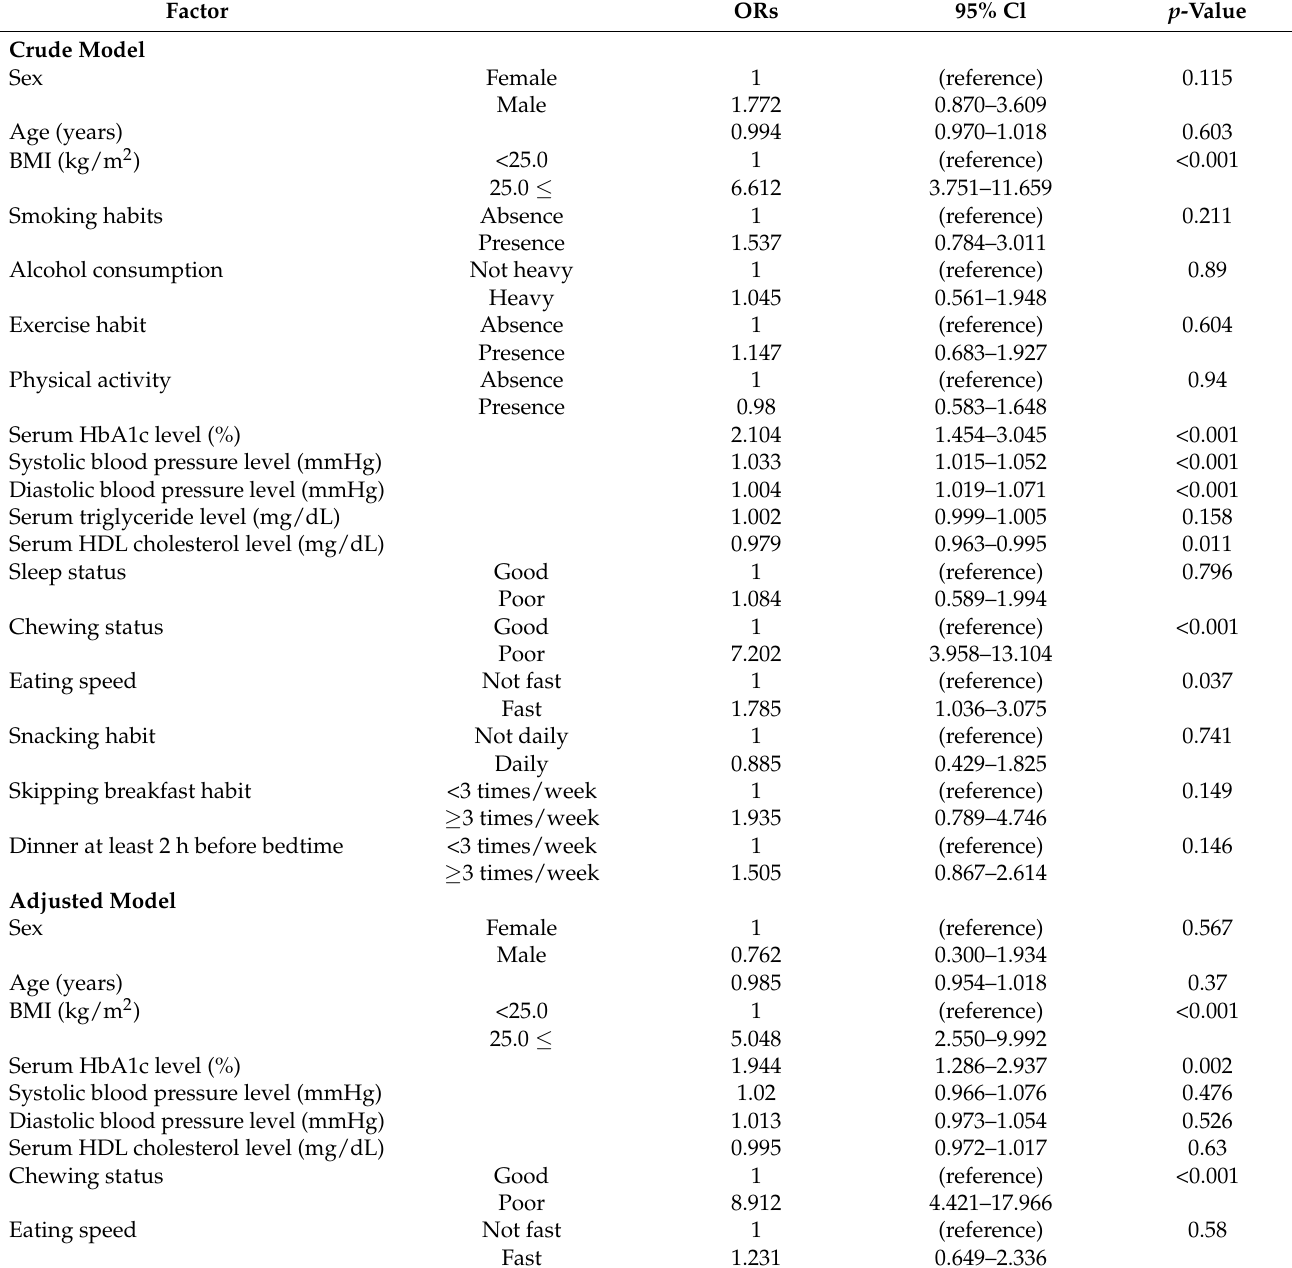
Table 2. Crude and adjusted odds ratios and 95% CI for fatty